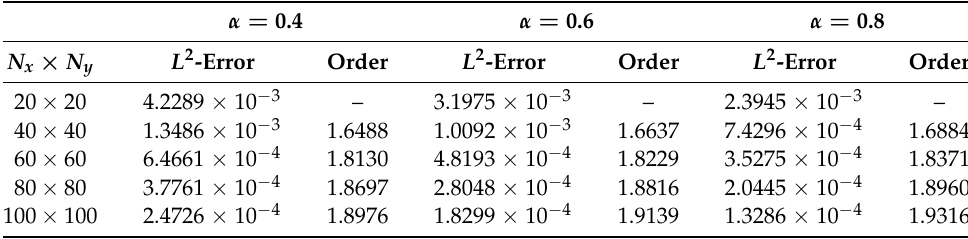
Table 3. The L 2 -norm errors and spatial convergence orders for Example 1 using scheme (18), M = 500, T = 1/4, r = ( 2 − α ) / α , k = 1. α = 0.4 α =